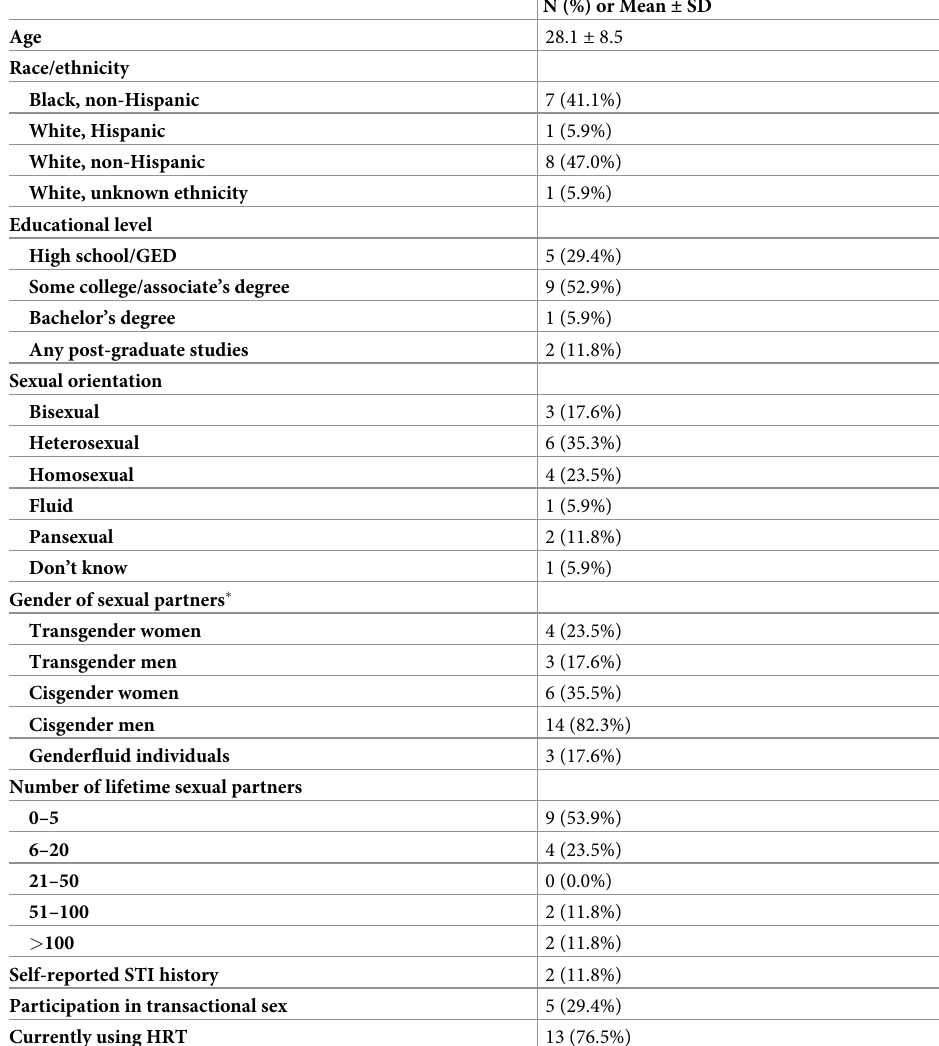
Table 2. Characteristics of transgender women participating in focus groups (n =